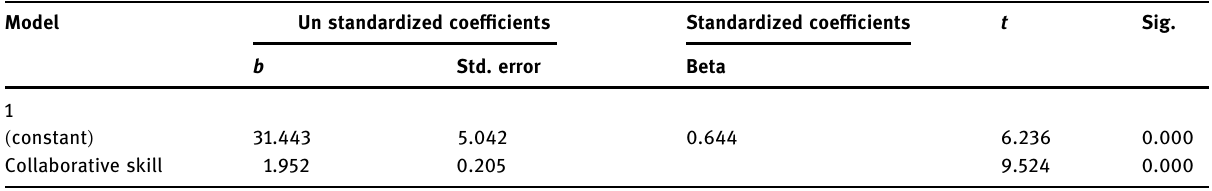
Table 8: Summary of regression analysis coe ffi cients